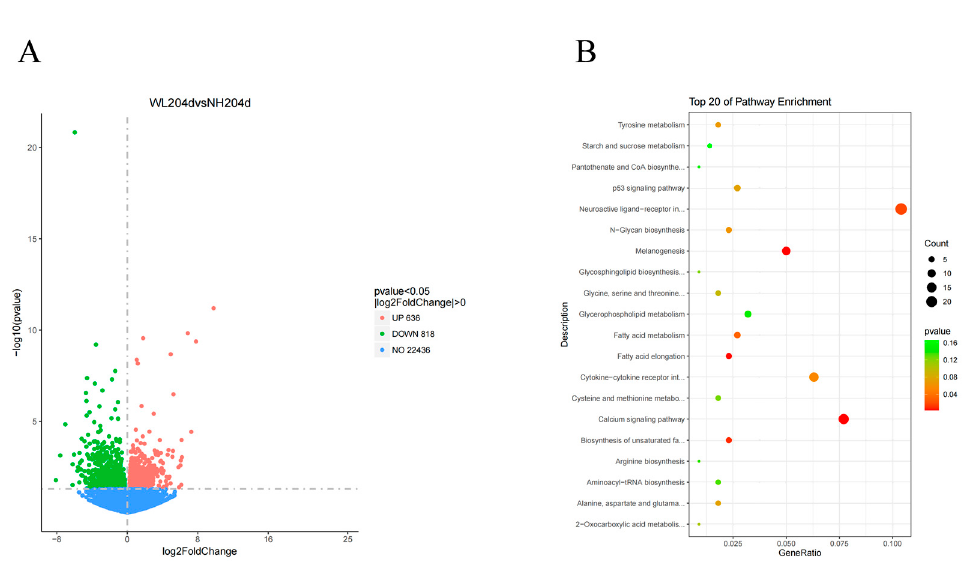
Figure 5. Bioinformatics analysis of hens with different egg production rates. ( A ) The volcano plot of differential genes in the ovaries of hens with different egg production rates. The x-axis represents the log2 fold change, the y-axis represents the statistical significance. The red dots indicate significantly up-regulated differential genes, the green dots indicate significantly down-regulated differential genes and the blue dots indicate no significant differential genes; ( B ) The top 20 KEGG terms presented in the enrichment analyses of ovary DEGs between high- and low-production hens.